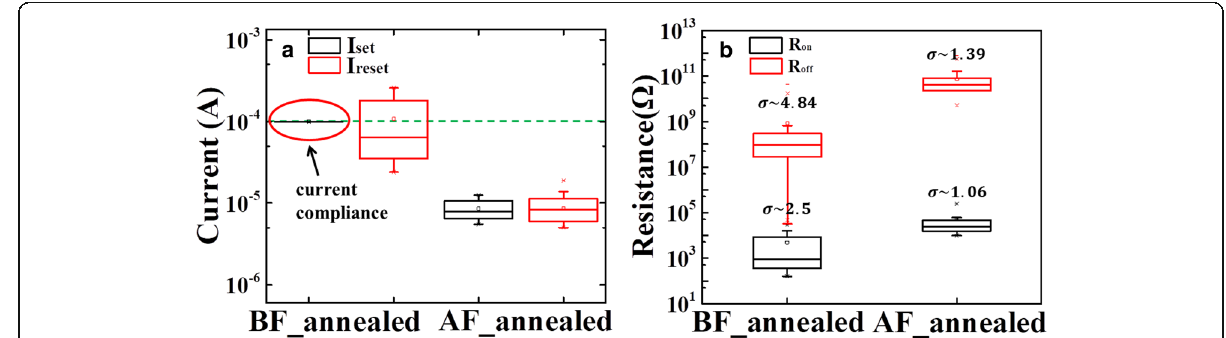
Fig. 3 a Set and RESET Current distributions before and after annealing, respectively. b The resistance distribution of HRS and LRS before/after